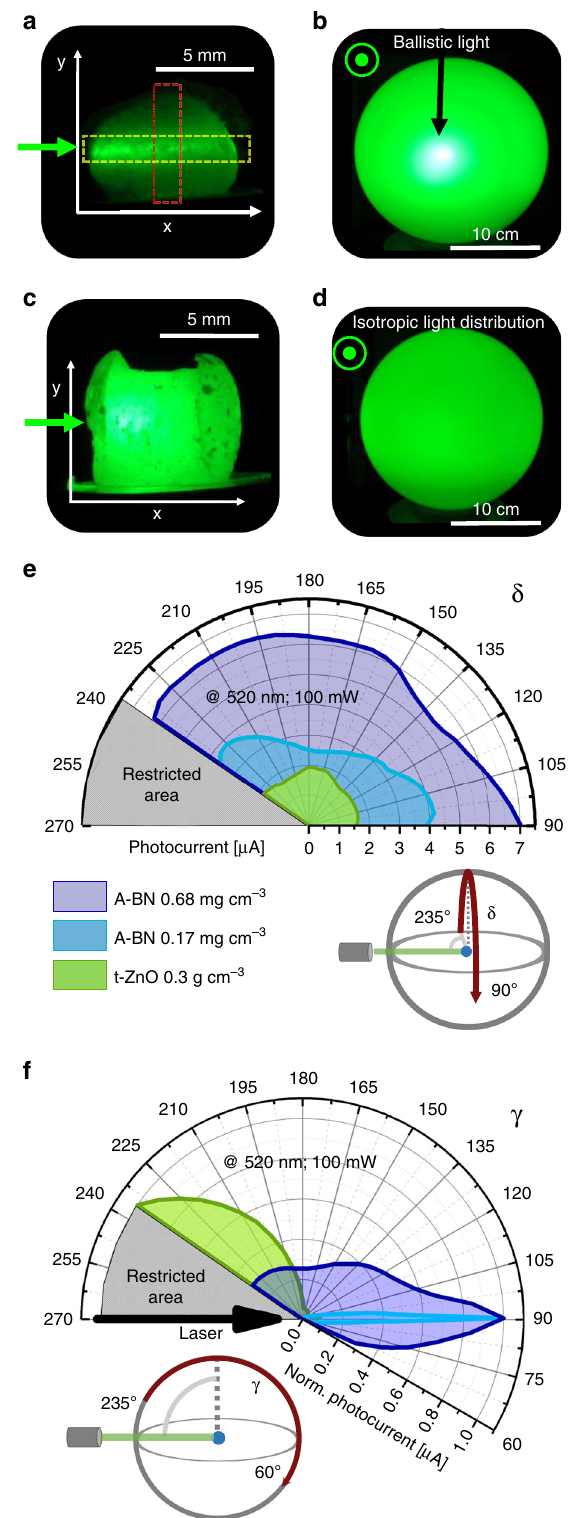
Fig. 4 Light-scattering characterisation. a Photograph of ρ Aero-BN ~0.17mg cm − 3 illuminated with 100mW (spot size ~1mm) at 520nm. b Photograph of the same sample shown in a when illuminated in the centre of a semitrans- parent glass bulb (front view). c , d Photograph of ρ Aero-BN ~0.68mgcm − 3 illuminated with 100mW at 520nm, and resultant light scattering imaged using a semitransparent glass bulb (front view). e Angular photocurrent dependence for Aero-BN with different ρ Aero-BN compared with an 100mW. The photodiode is polar rotated over the sample, as illustrated in the schematics. The graphs represent the photocurrent produced by scattered light only. f Corresponding normalised photocurrent with respect to the azimuthal rotation of the photodiode. For details of measurements see Supplementary Figs. 17